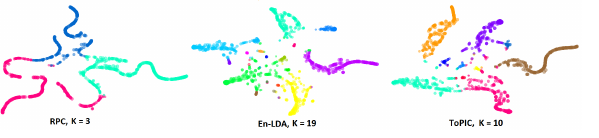
Figure 8. Comparison of t-SNE representations for dataset